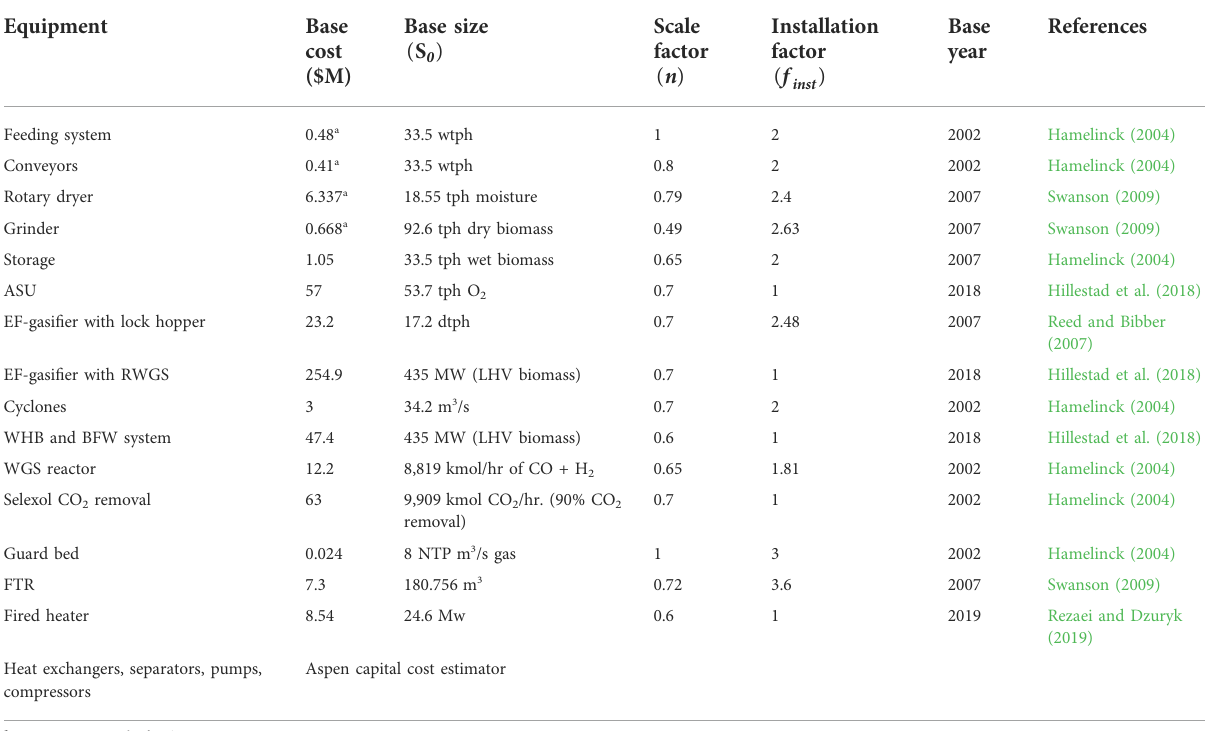
TABLE 5 Cost data used in the techno-economic analysis.